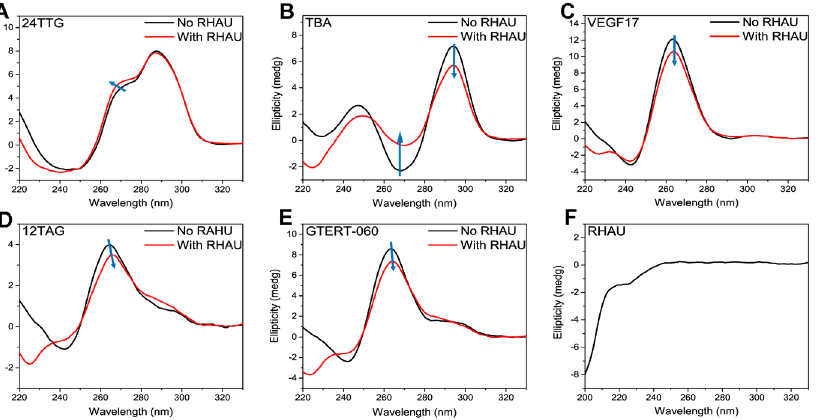
Figure 1. CD spectra of ( A ) 24TTG, ( B ) TBA, ( C ) VEGF17, ( D ) 12TAG and ( E ) GTERT-060 without (black lines) and with (red lines) RHAU at the ratio of 1:2 (10 μM G4s and 20 μM RHAU) after 30 min incubation at room temperature. ( F ) CD spectrum of RHAU (20 μM) dissolved in water. The blue arrows indicated the variation trend of CD signals from “No RHAU” to “With RHAU”.